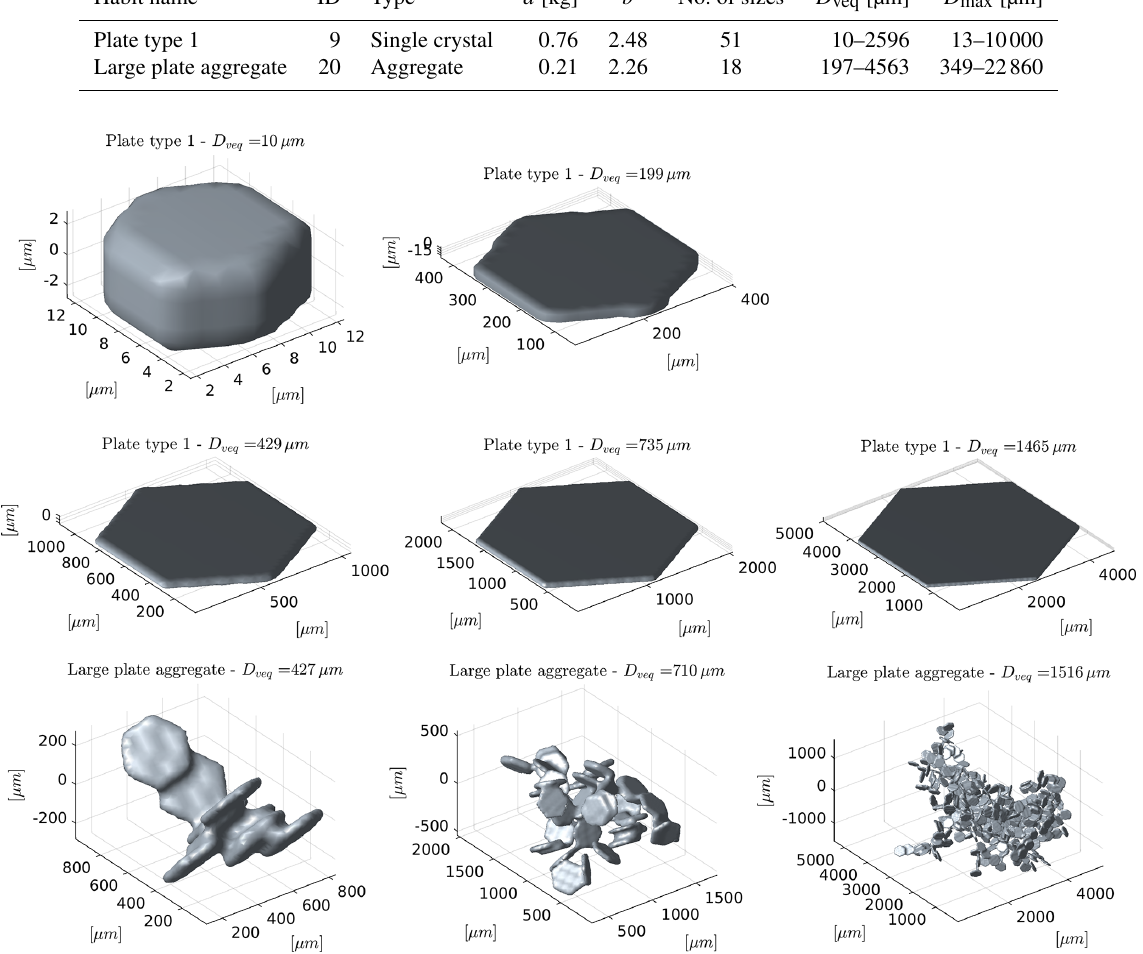
Figure 4. Example scatterer